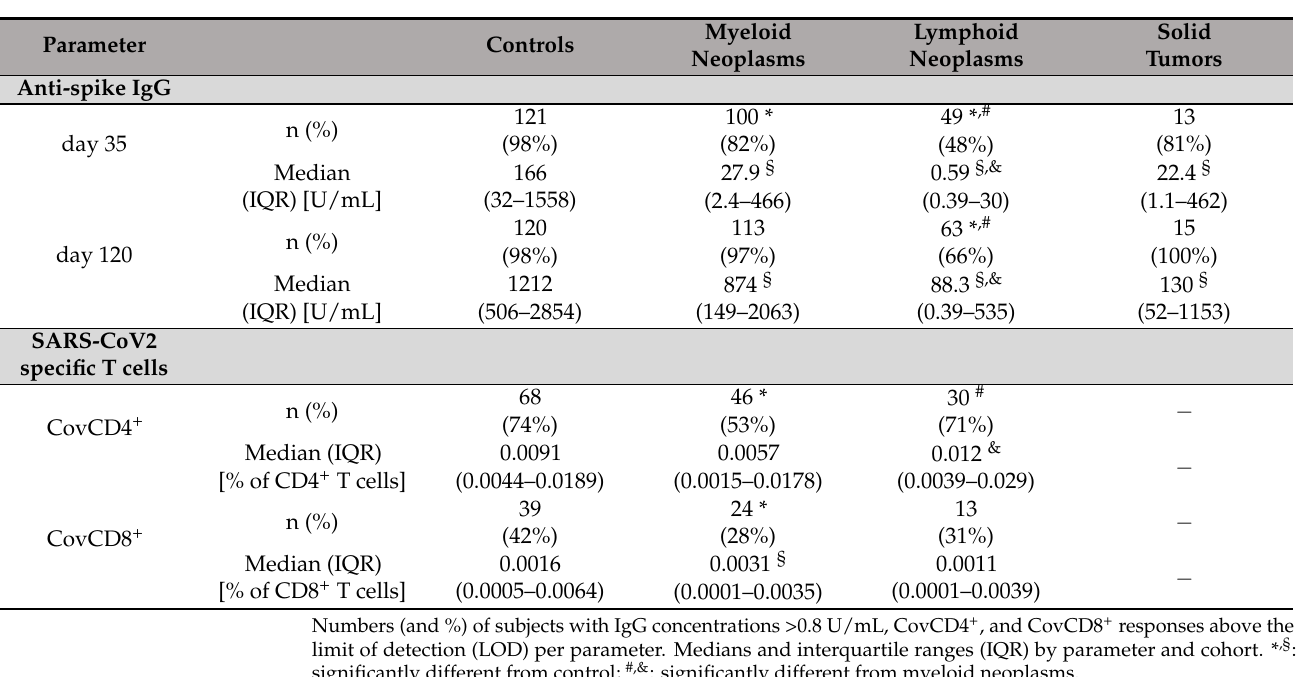
Table 3. Humoral and T-cell response to vaccination in controls and patient cohorts.